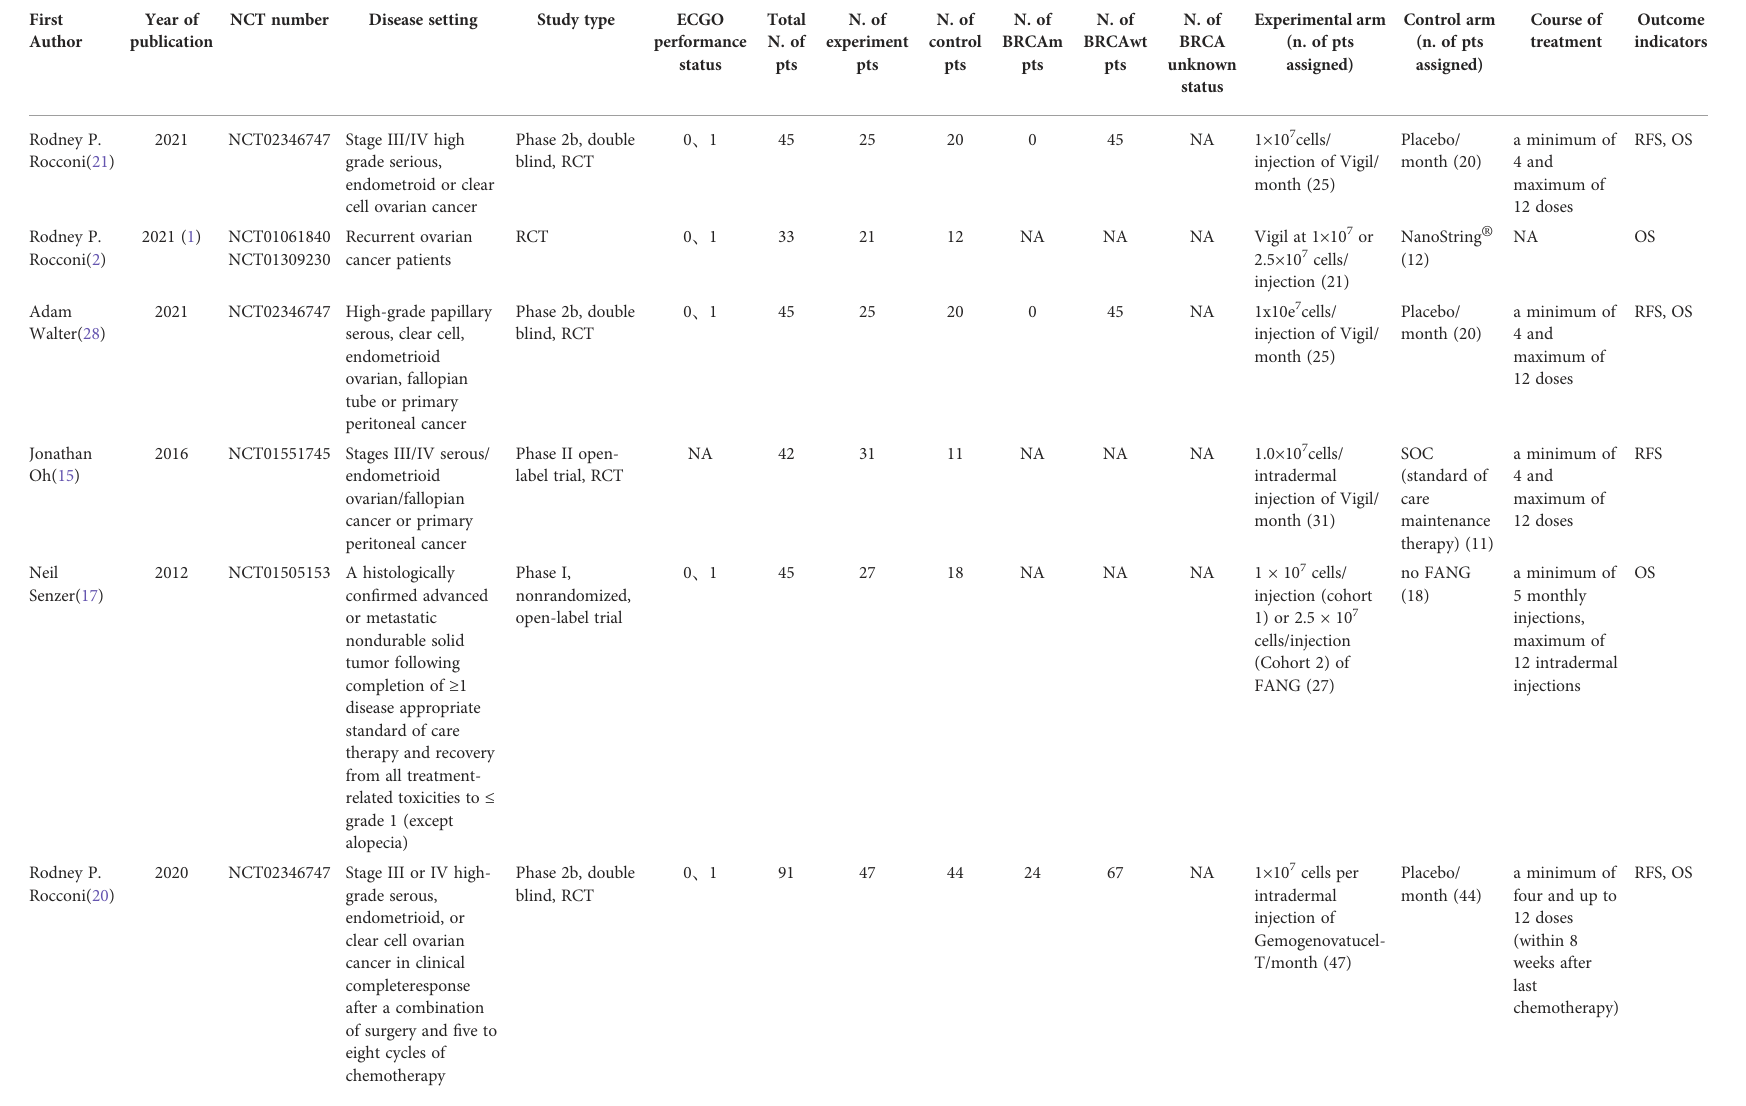
TABLE 1 General features of the included literature.